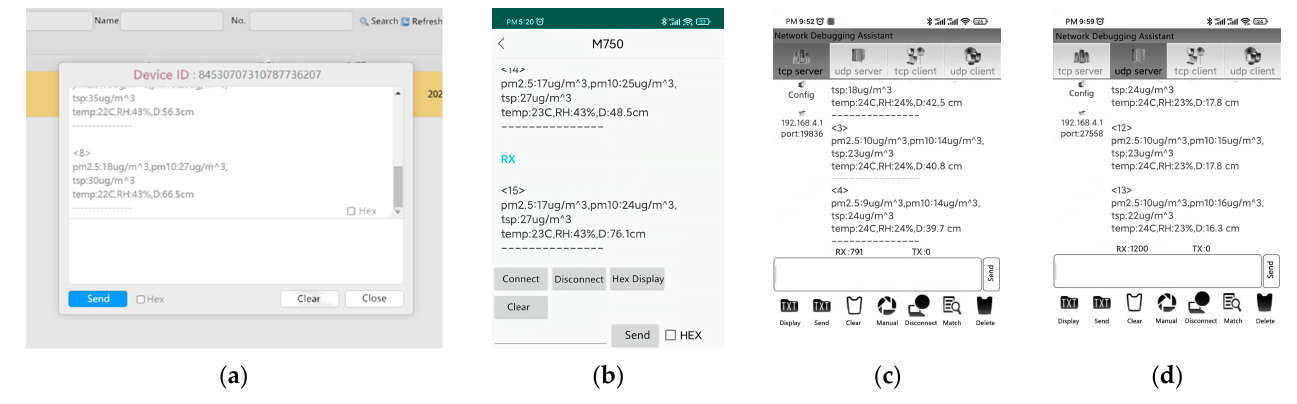
Figure 8. The monitoring interface of measurement data: ( a ) receiving data through browser in CLOUD mode; ( b ) developed app on Android platform for CLOUD mode; ( c ) TCP mode; ( d ) UPD mode.